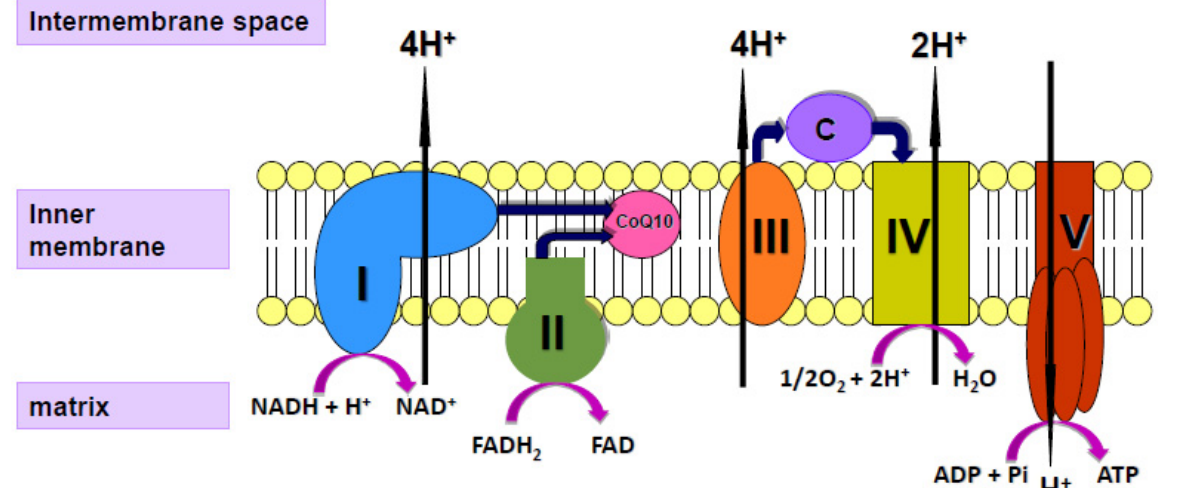
Figure 1. Diagram of the mitochondrial respiratory chain (MRC) showing the enzyme complexes I V and the electron carriers’ coenzyme Q10 (CoQ10), cytochrome c (C) and protons (H +